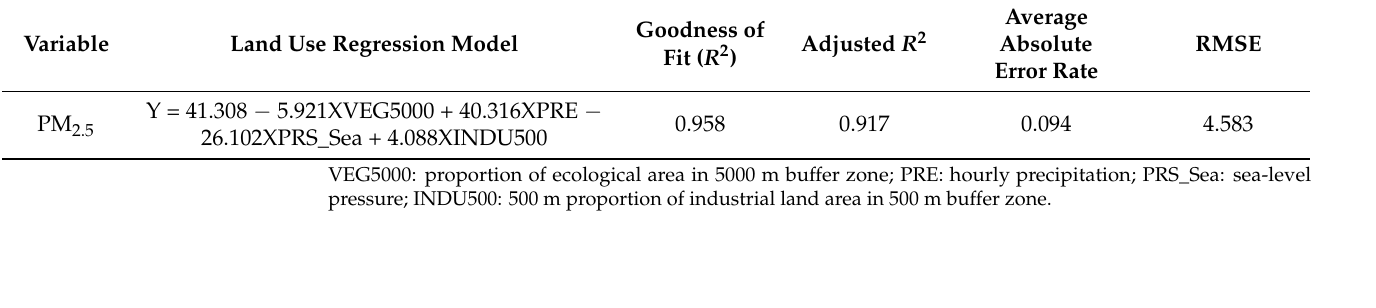
Table 7. Results of LUR